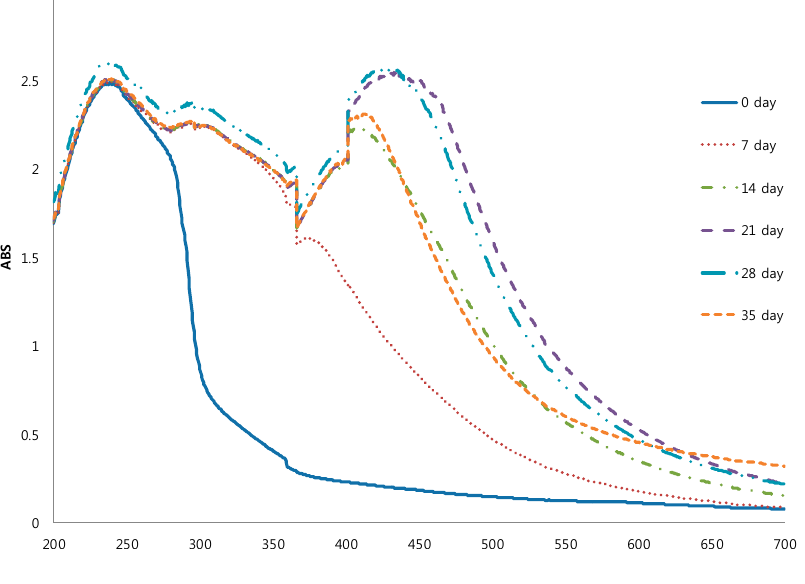
Figure 2. Visible spectra of black garlic during the aging